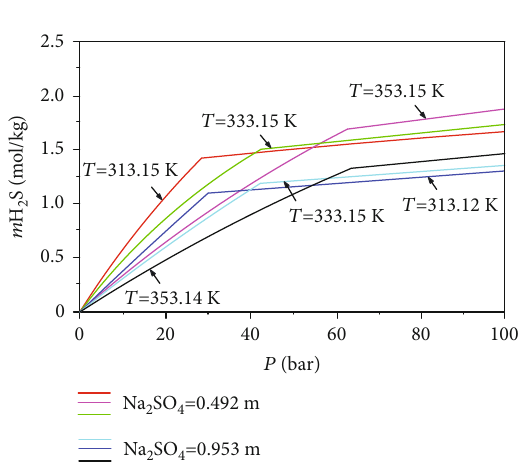
S in NaCl solution. 2